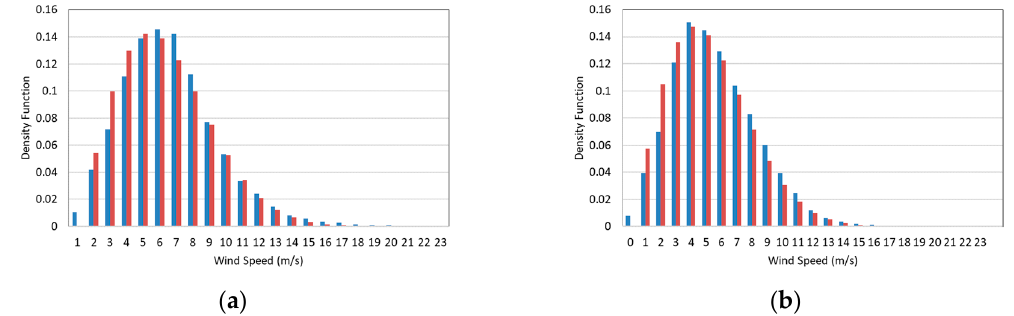
Figure 7. Normalized histogram of wind speeds, in blue, and fitted Weibull distribution, in red, for: ( a ) 2010; and ( b ) 2011. The Weibull parameters are k = 2 and λ = 5.99 and k = 2 and λ = 5.82, for 2010 and 2011, respectively.